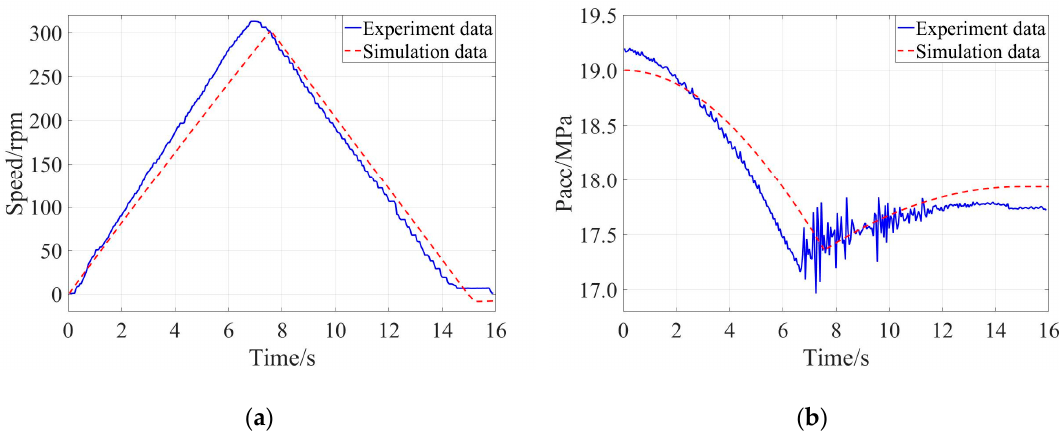
Figure 11. Comparison of the experimental result and simulation result when the braking intensity was 0.40: ( a ) Evolution of speed of the flywheel, ( b ) Evolution of pressure of the accumulator.